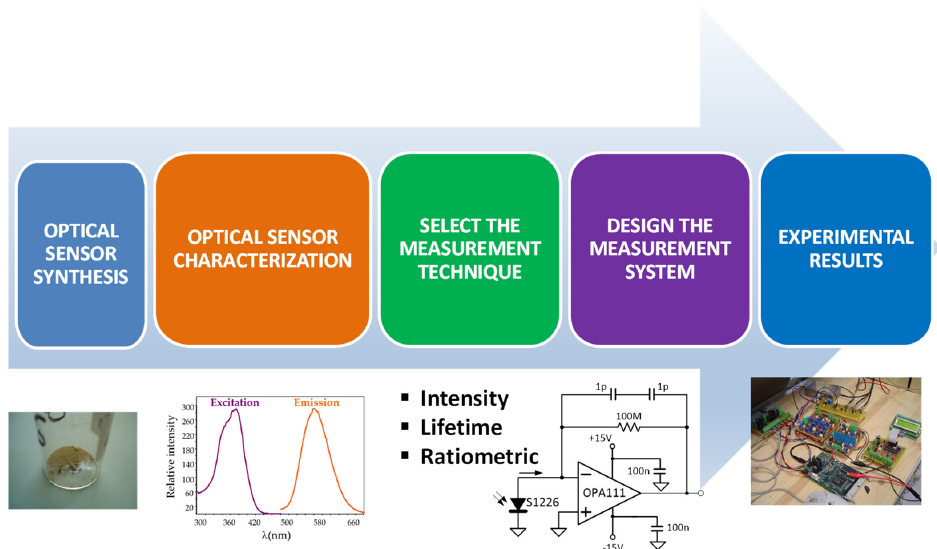
Figure 13. Design flow for an optoelectronic instrumentation system involving optical sensors.